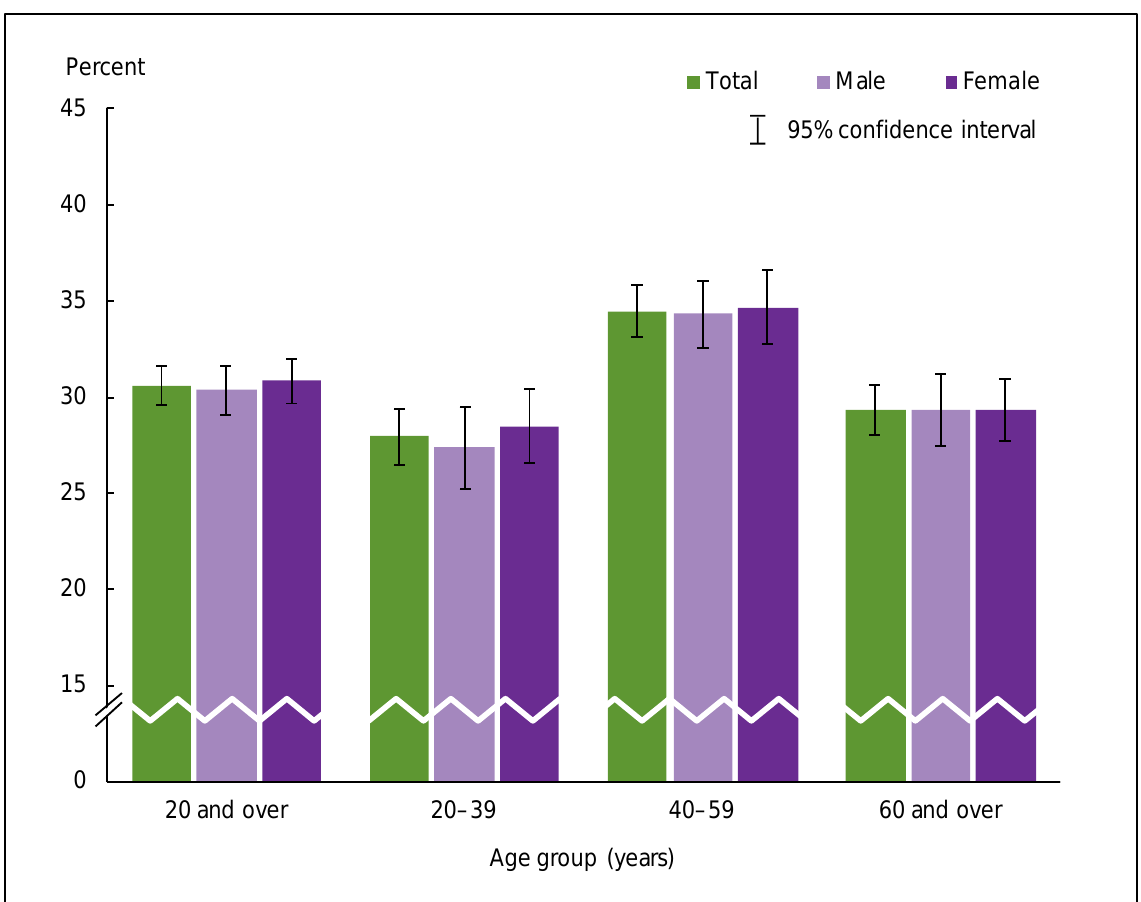
Figure 6.2. Prevalence of obesity among adults aged 20 and over, by age group and sex: United States,